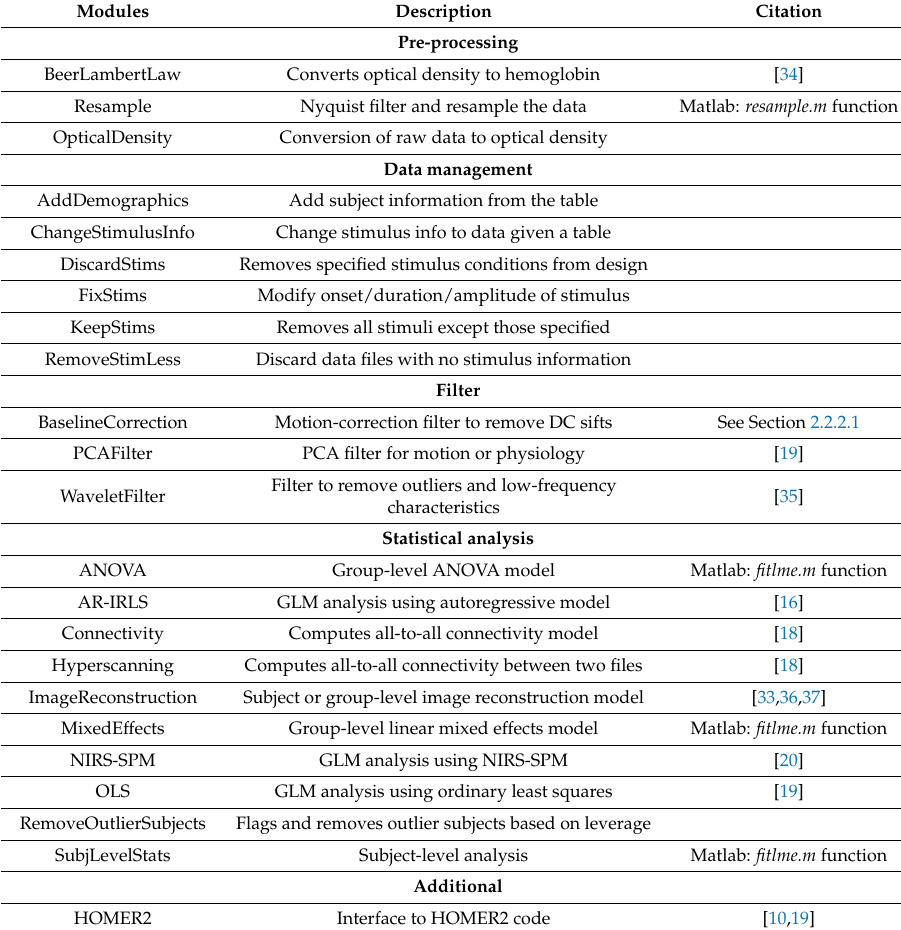
Table 2. List of the basic processing modules in the AnalyzI R